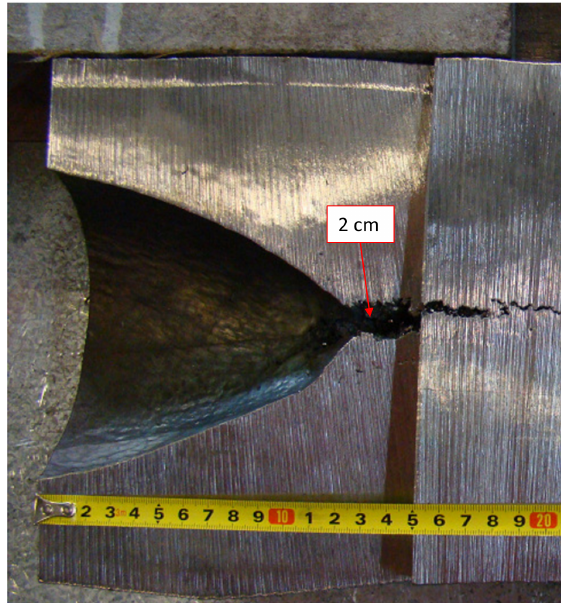
Figure 6. Section of a tube after 0.5 s of piercing